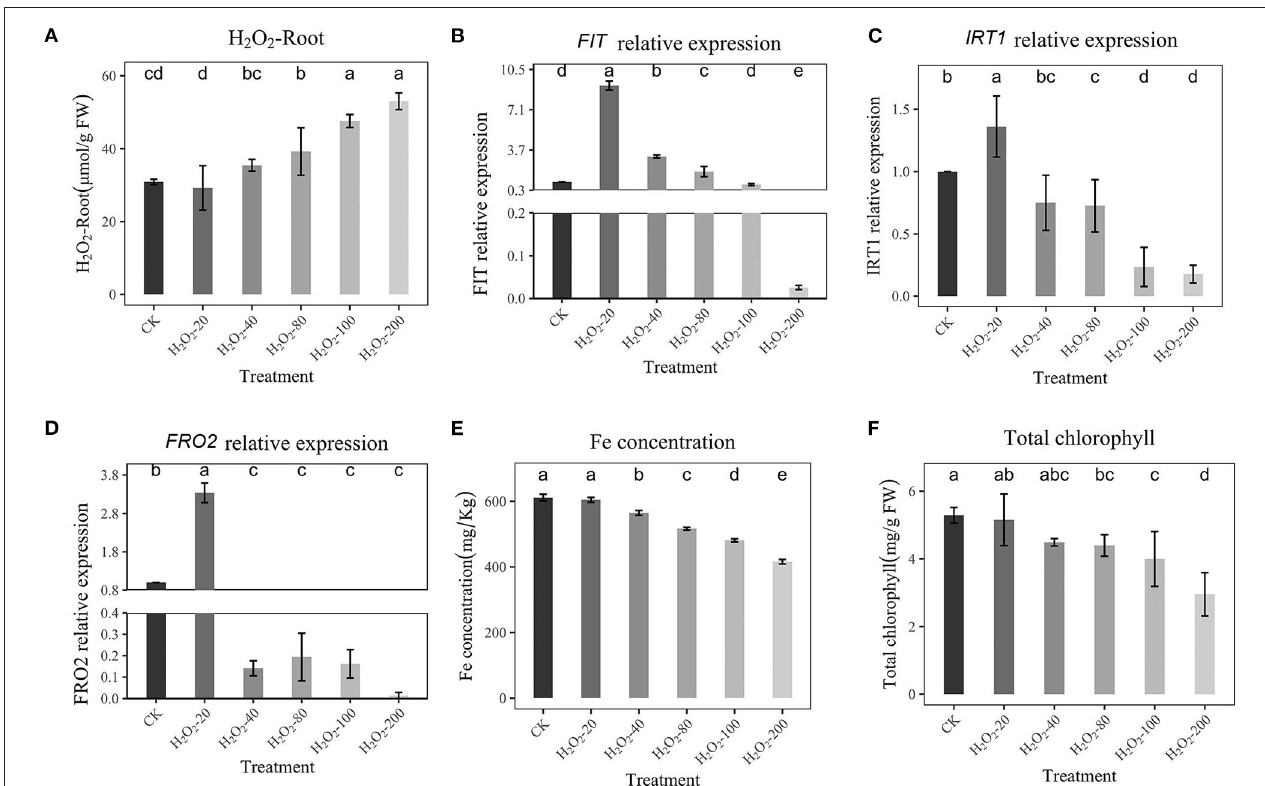
FIGURE 4 | Effects of Hoagland nutrient solution with different H 2 O 2 concentration on peanut with adequate Fe (A) : Effects of Hoagland nutrient solution with different H 2 O 2 concentration on root H 2 O 2 content. (B) : Effects of Hoagland nutrient solution with different Fe concentration on FIT expression. (C) : Effects of Hoagland nutrient solution with different H 2 O 2 concentration on IRT 1 expression. (D) : Effects of Hoagland nutrient solution with different H 2 O 2 concentration on FRO2 expression. (E) : Effects of Hoagland nutrient solution with different H 2 O 2 concentration on Fe concentration. (F) : Effects of Hoagland nutrient solution with different